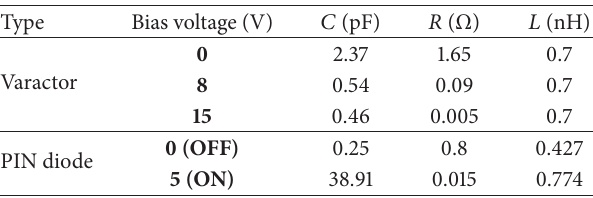
Table 2: Effective parameters of the circuits.